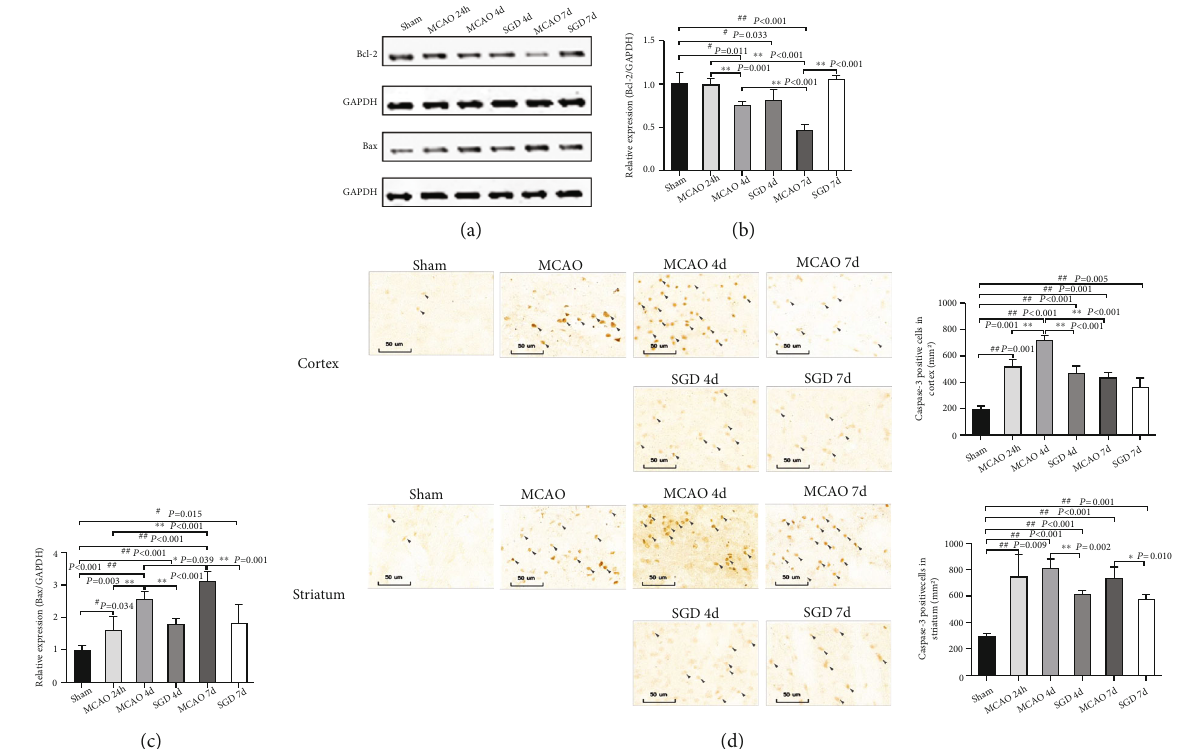
Figure 8: SGD reduced apoptotic cell numbers after CI/RP. We detected Bcl-2 and Bax levels by western blotting and apoptotic cells by immunohistochemistry ( × 200) of caspase-3 in the penumbra in the sham, MCAO, and SGD groups to assess the bene fi t of SGD after MCAO. (a) Representative bands of Bcl-2, Bax, and GAPDH. The statistical analysis of Bcl-2 (b) and Bax (c) was also presented graphically on the right side. n = 4 for each group. (d) Representative images of cell apoptosis (indicated by black arrows), and the statistical results of the number of positive cells were plotted as a histogram. Scale bar = 50 μ m , n = 3 for each group. # P < 0 : 05 , ## P < 0 : 01 vs. sham; ∗ P < 0 : 05 , ∗∗ P < 0 : 01 vs.